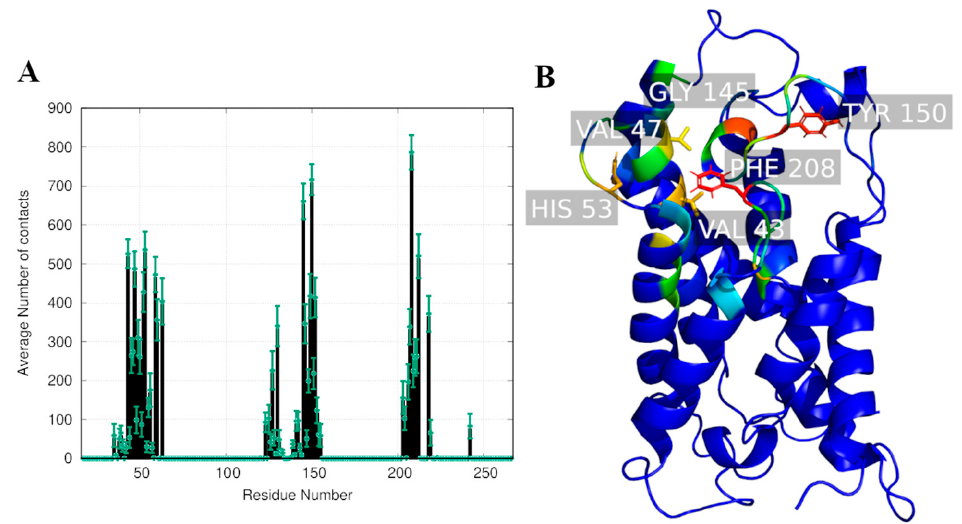
Figure 7. ( A ) Average number of contacts established between RoT and AQP3 residues throughout all the MD replicate simulations (between 100 ns to 200 ns of simulation). ( B ) Identification of the residues with higher number of contacts established between RoT and AQP3. The color code used ranges between red (highest number of contacts) to dark blue (lowest number of contacts).